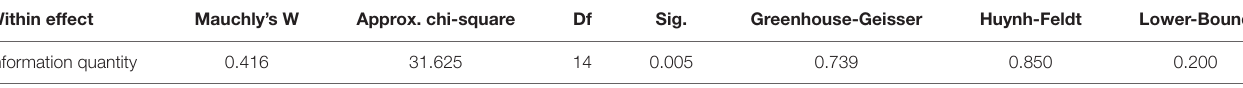
TABLE 9 | Mauchly’s test of sphericity.